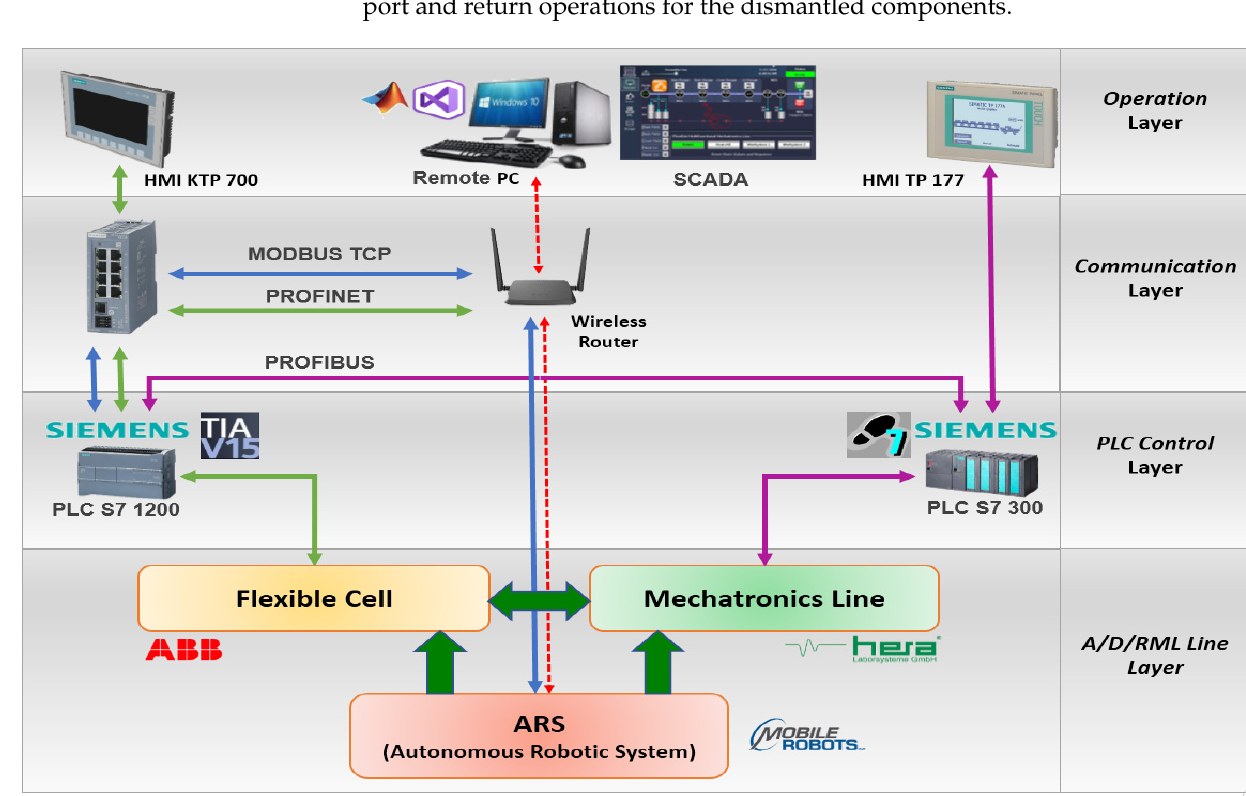
Figure 1. Structure of A/DML Hera&Horstmann and Flexible Cell ABB served by ARS.